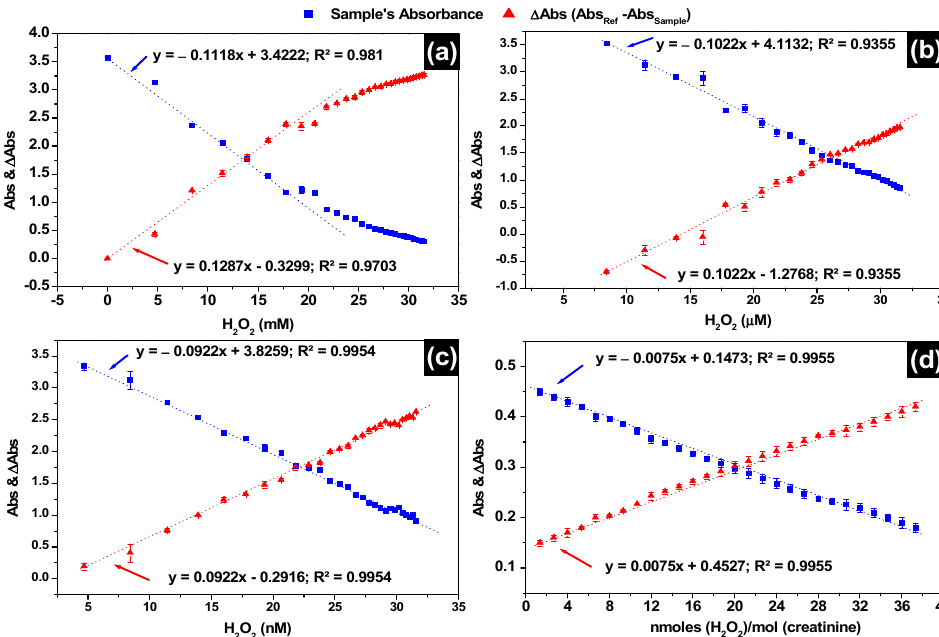
Figure 4. Calibration curves of H 2 O 2 detection using LSPR absorbances of the β CD-AgNPs and LSPR Δ Absorbance between the reference and the sample ( a ) 4.7 to 32.0 mM H 2 O 2 range; ( b ) 4.7 to 32.0 μ M H 2 O 2 range; ( c ) 4.7 to 32.0 nM H 2 O 2 range; ( d ) 1.3 to 37.3 nmoles of H 2 O 2 /mole of creatinine range in the presence of 10 mM creatinine. Absorbances in all experiments are recorded at LSPR λ max = 384 nm and nanoparticles were diluted 3 times. In Figure 5a,b the calibration curves used to assess the levels of H 2 O 2 in freshly voided midstream urine of the 7 healthy men aged between 20 and 40 years are presented, using the assay kit and the LSPR of β CD-AgNPs , respectively. Linear responses are ob- tained for both tests. For the assay kit a linear response was in the range of 1.0 nmoles to 10.0 nmoles (10–100 µ M) with a slope of 0.0785 and a regression coefficient of 0.995, while a linear response 1.33 to 37.3 nmoles of H 2 O 2 /moles of creatinine with a slope of 0.0075 and regression coefficient of 0.9955 when the β CD-AgNPs test is used in the presence of 10.0 mM of creatinine. The concentration of H 2 O 2 is dependent on the dilution for all participants, except KU-22, all participants showed lower concentration of H 2 O 2 when samples are diluted 10 times and the assay kit is used (Figure 5c). The average concen- tration of H 2 O 2 in urine using the assay kit is found to vary between 2.11 ± 0.048 nmoles (21.1 ± 0.48 µ M) and 3.22 ± 0.046 nmoles (32.2 ± 0.46 µ M) when the matrix is not diluted, between 1.38 ± 0.042 nmoles (13.8 ± 0.42 µ M) and 2.52 ± 0.019 nmoles (25.2 ± 0.19 µ M) when the matrix is diluted twice and between 0.60 ± 0.051 nmoles (6.0 ± 0.51 µ M) and 1.12 ± 0.050 nmoles (12.1 ± 0.50 µ M) when the matrix is diluted 10 times. In this